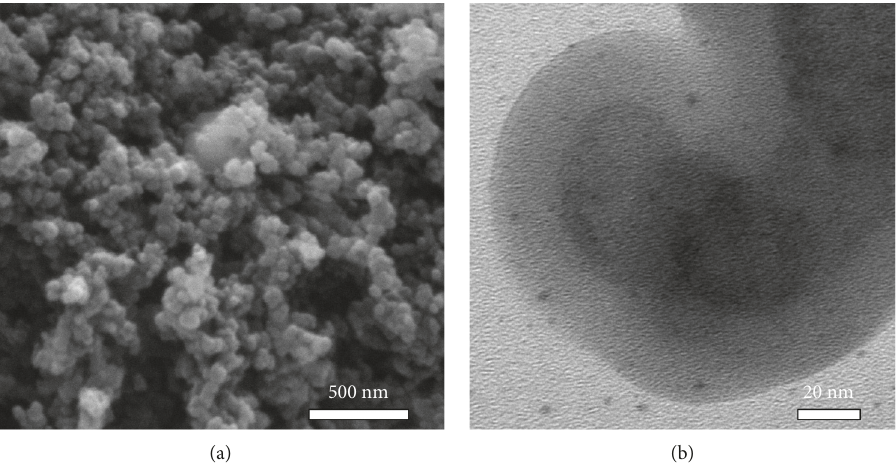
Figure 7: (a) SEM and (b) TEM images of the nanosilver-coated carbon black (AgCB) used as the additive for fabrication of x AgCB-PBS composites ( x � the percentages of AgCB filler with respect to the PBS content).